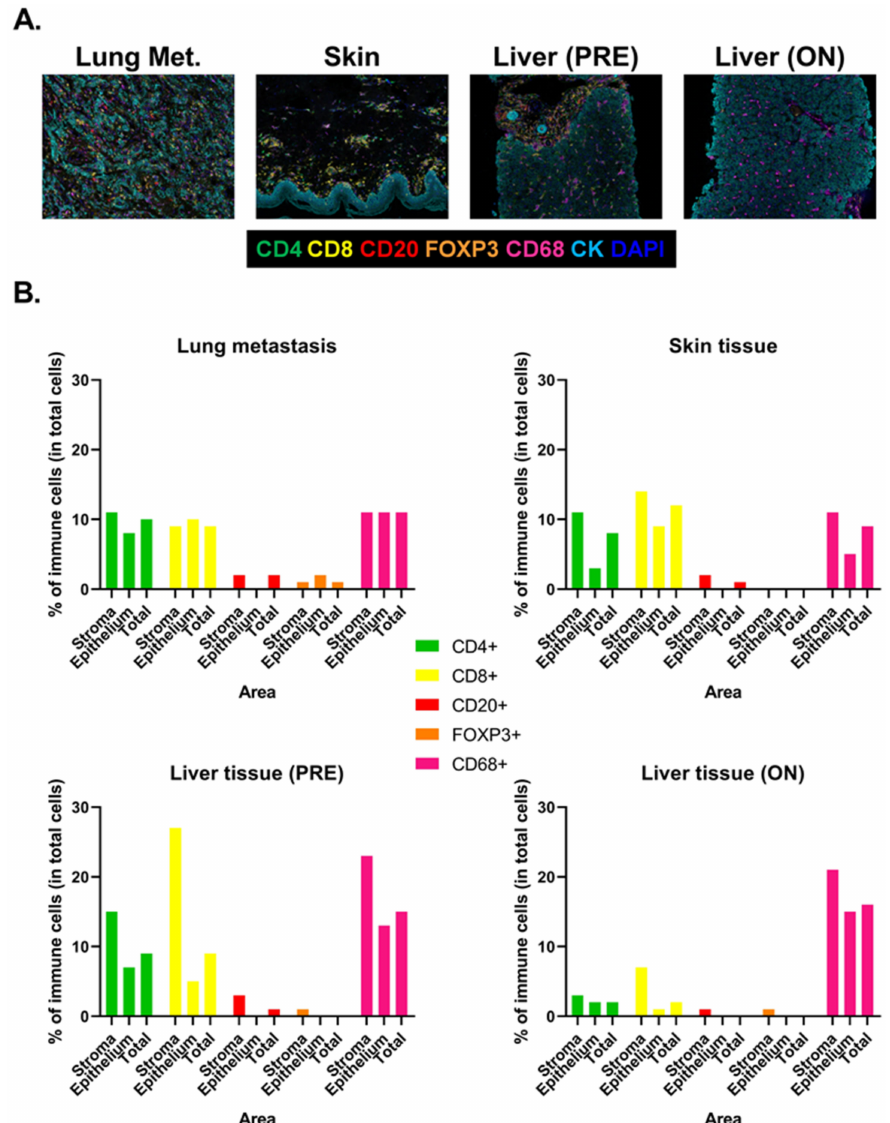
Figure 3. Tissue immune infiltration at disease progression and at the onset of toxicities. ( A ): Representative fluorescent multiplexed IHC images of lung metastasis, skin tissue, and liver tissues before (PRE) and during (ON) immunosuppressive therapy. Tumor-infiltrating lymphocytes were revealed by CD20 (red), CD8 (yellow) and CD4 (green), FOXP3 (blue), CD68 (magenta), and tumor cells by panCK (cyan). ( B ): Quantification of immune cell (as percentage of total cells) within the stroma, the epithelium, and total area of each